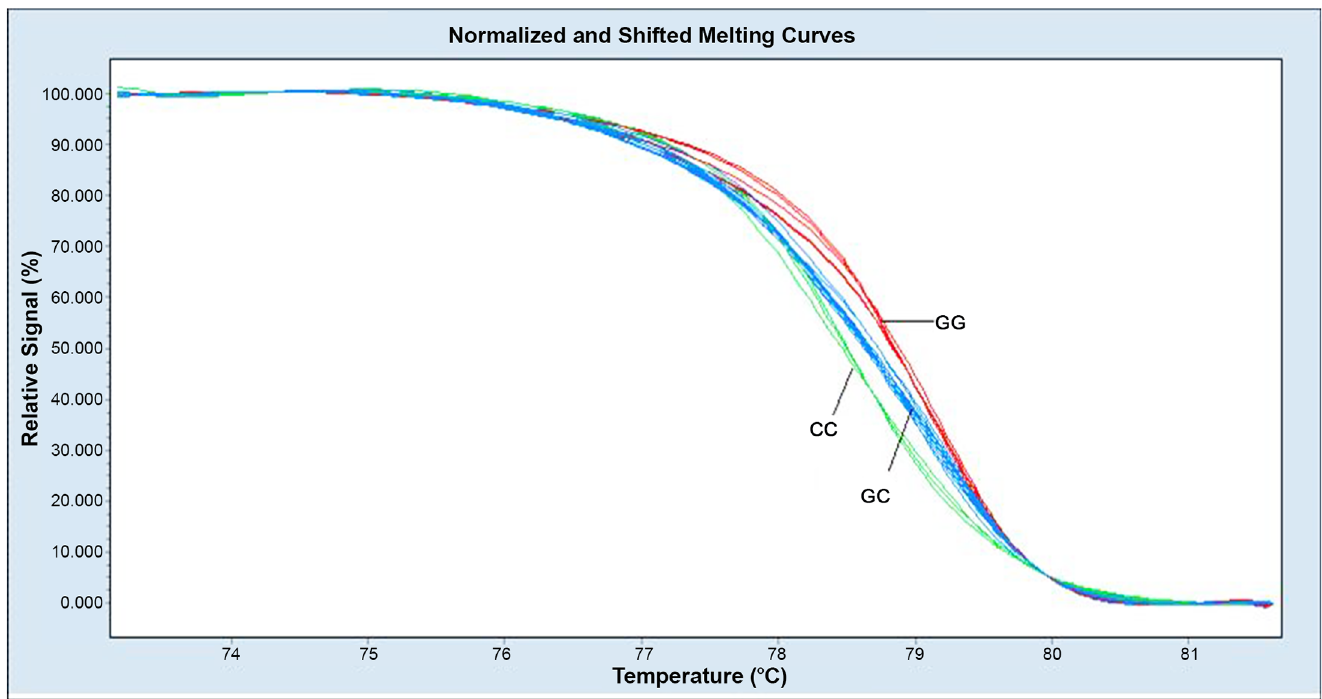
Fig 1. Melting profiles for the three genotypes from the normalized melting